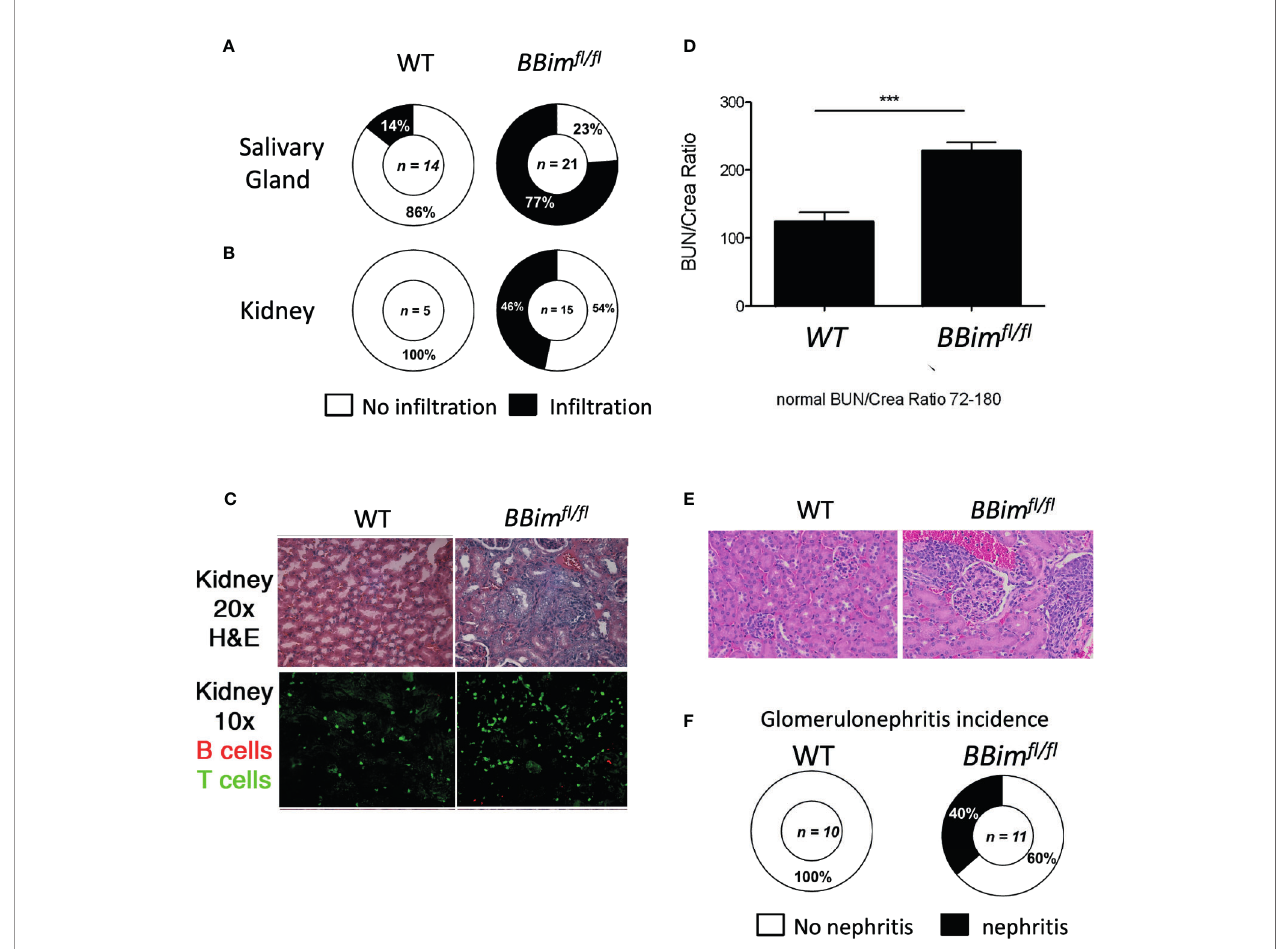
FIGURE 3 | BBim fl / fl mice exhibit multiorgan lymphocyte in fi ltration and kidney damage. Tissues from ≥ 6 month old WT (n ≥ 3) and BBim fl / fl (n ≥ 8) mice were assessed for tissue damage. Representative pie charts show incidence of in fl ammation in the (A) salivary glands, and (B) kidneys. (C) Representative H&E images showing glomeruli in kidney sections (top panels) and immuno fl uorescence images of kidney sections (bottom panels) showing in fi ltrated T cells (green) and B cells (red) (D) Blood urea nitrogen and plasma creatine levels (BUN/crea) in the blood (age ≥ 6 month old) (E) H&E stained images of kidney sections showing enlarged glomeruli (glomerulonephritis) in BBim fl / fl relative to WT mice. (F) Incidence of kidney damage in the BBim fl / fl and WT mice. ***P ≤ 0.001, calculated by Students